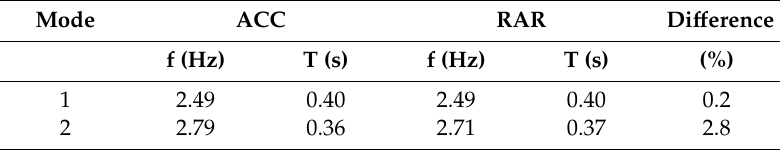
Table 3. Comparison of the resonant frequencies and periods corresponding to the first and second mode, obtained with the contact method, using accelerometers, and the remote sensing technique, using RAR.